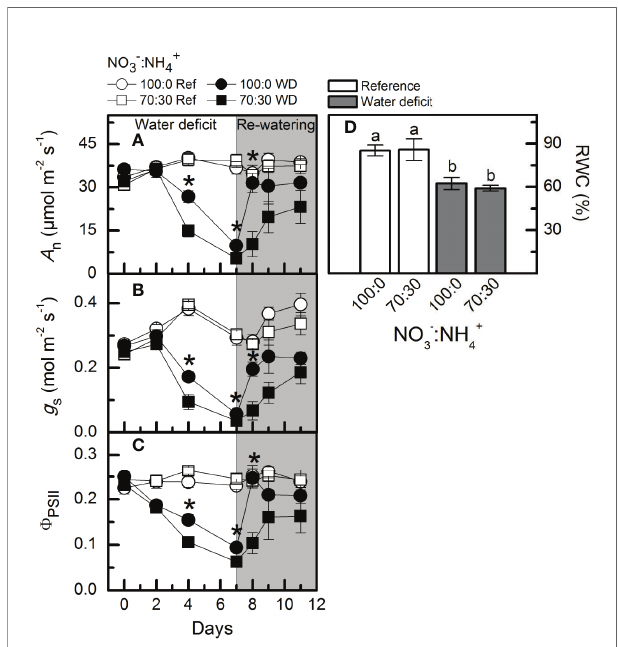
FIGURE 6 | Net CO 2 assimilation rate [ A n , in (A) ], stomatal conductance [ g S , in (B) ], effective quantum ef fi ciency of PSII [ F PSII , in (C) ] and leaf relative water content [RWC, in (D) ] in sugarcane plants maintained well-hydrated (ref, white symbols and bars) or subjected to water de fi cit (WD, black symbols and gray bars) and supplied with varying NO 3 − :NH 4+ ratios: 100:0 and 70:30. The white area indicates the period of water de fi cit and the shaded area indicates the period of re-water. Symbols and bars represent the mean value of four biological replicates ± se. Asterisks indicate signi fi cant differences between treatments under water de fi cit and different letters indicate statistical difference (BF 10 > 3) among treatments in a given